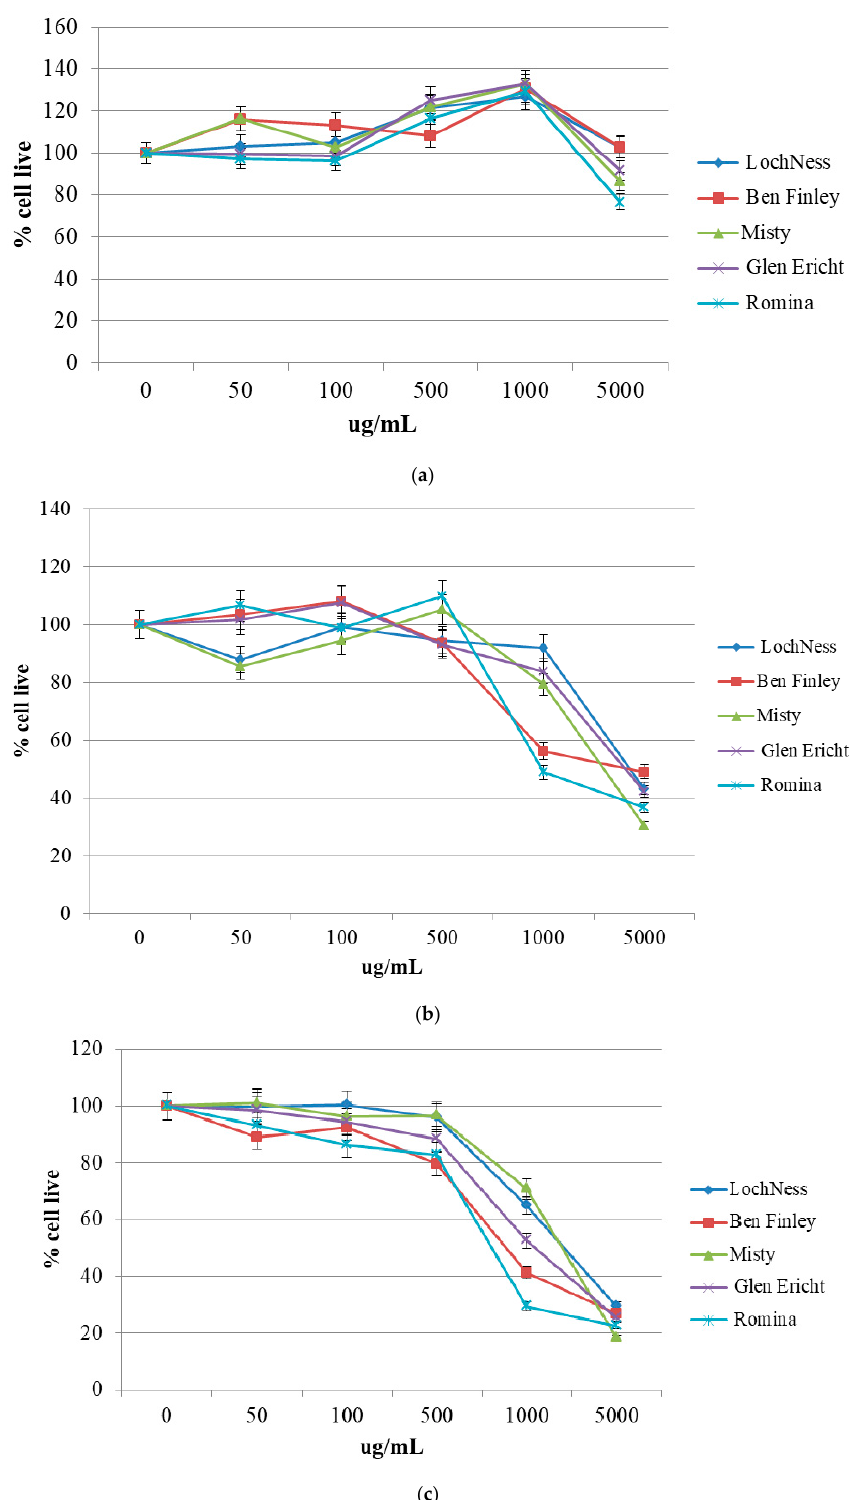
Figure 2. Viability of HepG2 determined by 3-(4,5-dimethylthiazol-2-yl)-2,5-diphenyltetrazolium bromide (MTT) assay. Cells were treated with various concentrations of berry digested extracts (0–5000 μ g/mL) for 24 h ( a ), 48 h ( b ) and 72 h ( c ). Data are expressed as mean ± SD for eight replicas ( n = 8) of three independent experiments.